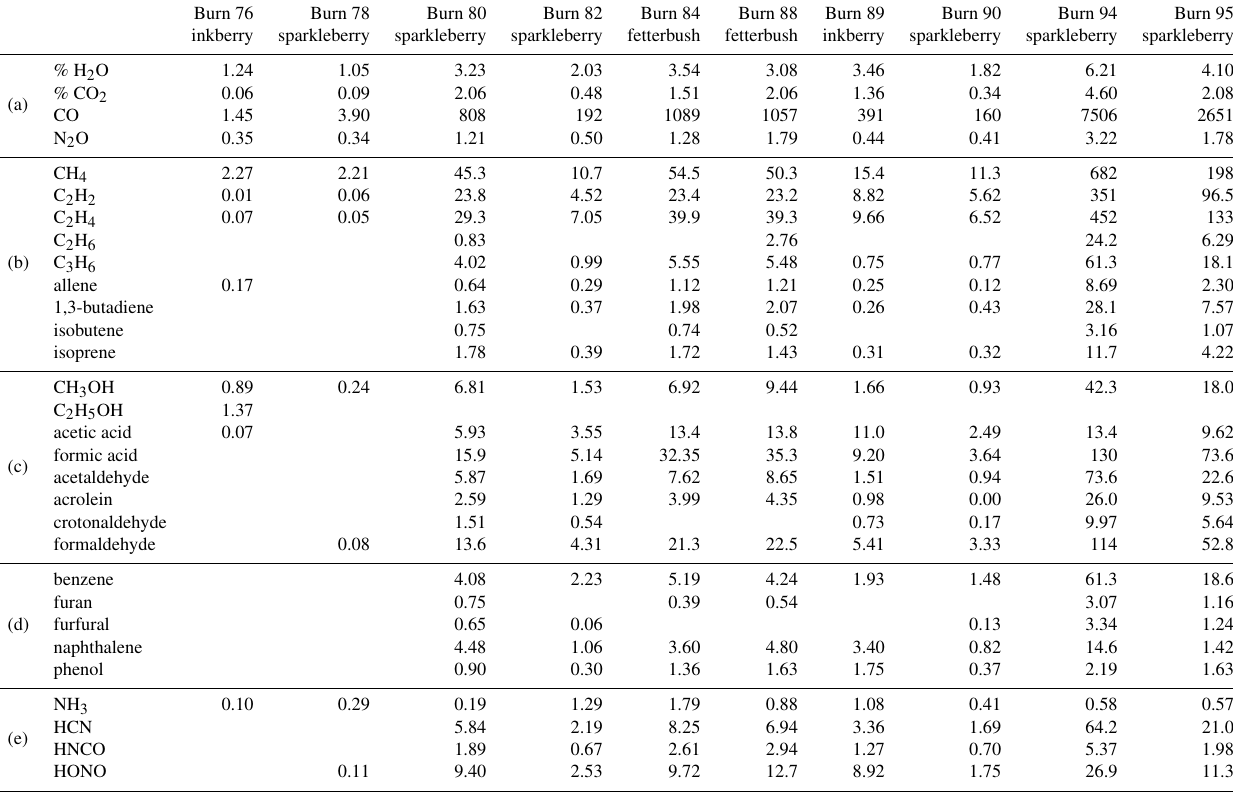
Table 2. Mixing ratio of chemicals from spectra collected using the static acquisition method. Burns are labeled by number and plant species. Mixing ratios are reported in parts per million (ppm) (with the exception of H 2 O and CO 2 reported as percents) and categorized by (a) background ambient compounds, (b) simple hydrocarbons, (c) oxygenated organic compounds, (d) aromatics and furans, and (e) N- bearing species.